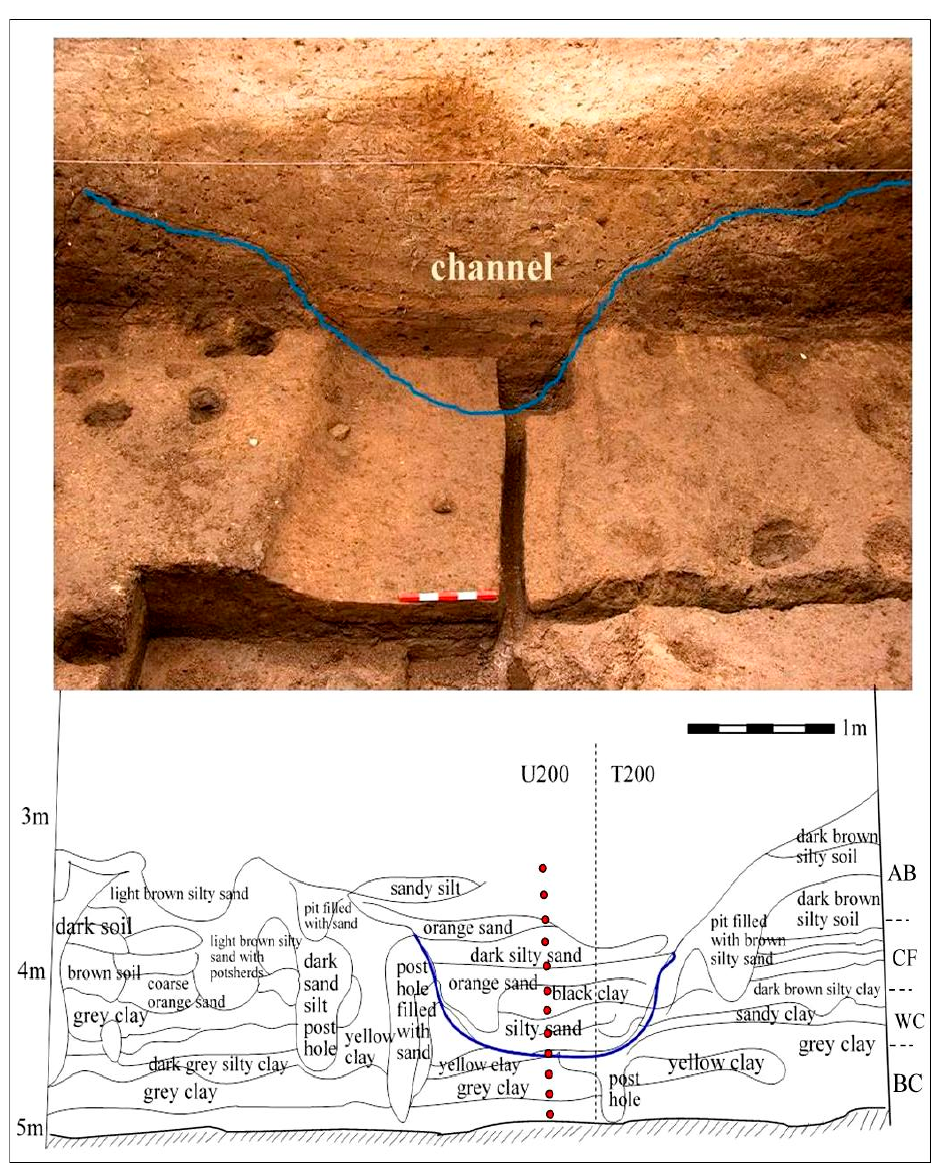
Figure 3. Sampling context across the U200 channel. Photograph shows the U200 excavation across the channel feature. Section plan indicates the channel standing with surrounding stratigraphy (Red dots show the sampling contexts of above channel (AB), channel fill (CF), within channel (WC) and below to the channel (BC) sediments), (photograph: Nigel Chang, line diagram: Nelum Kanthilatha).